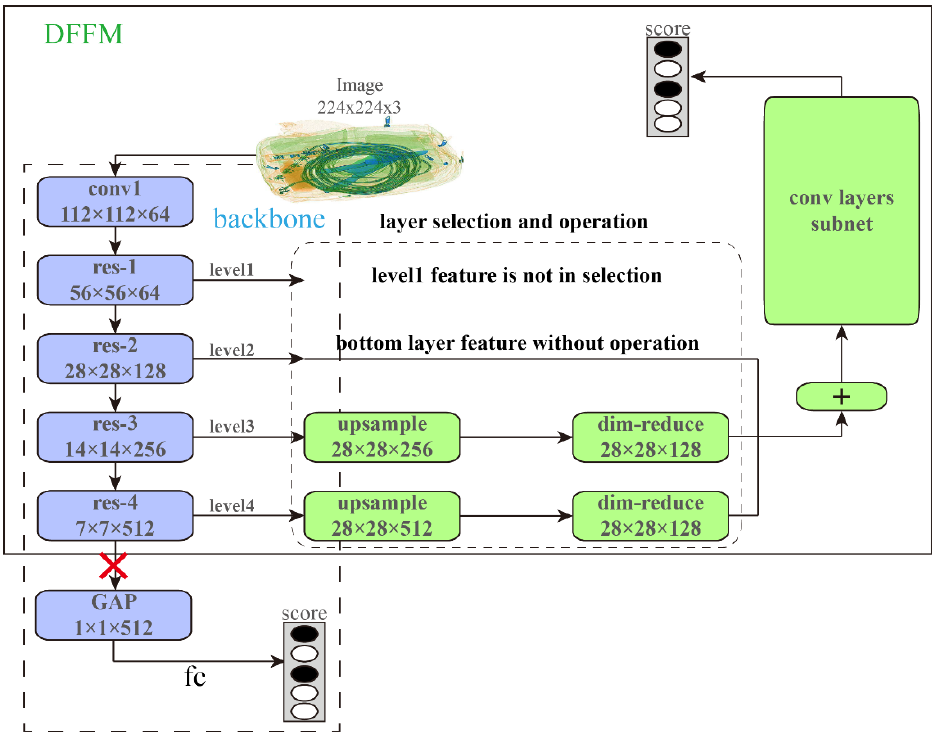
Figure 2. Proposed Deep Feature Fusion Model (DFFM) architecture. Components in leftmost dashed box belong to backbone model (e.g., ResNet34 in this figure). Components in the whole solid box comprise the model proposed in this paper. Numbers (H × W × C) in blocks indicate the output dimension.